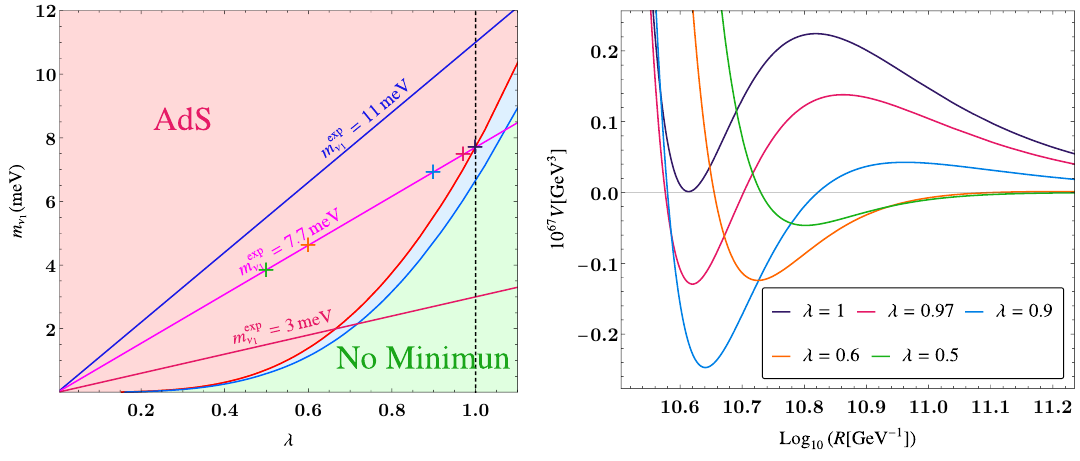
Figure 4 . Left: lightest neutrino mass versus the scanning parameter λ for Dirac neutrinos. The cosmological constant also changes as Λ from the AdS to the runaway area as long as the lightest neutrino mass is m exp in this figure we show how the potential changes along the scanning for m exp Coloured crosses in the left hand side correspond to the coloured curves in the plot on the right hand